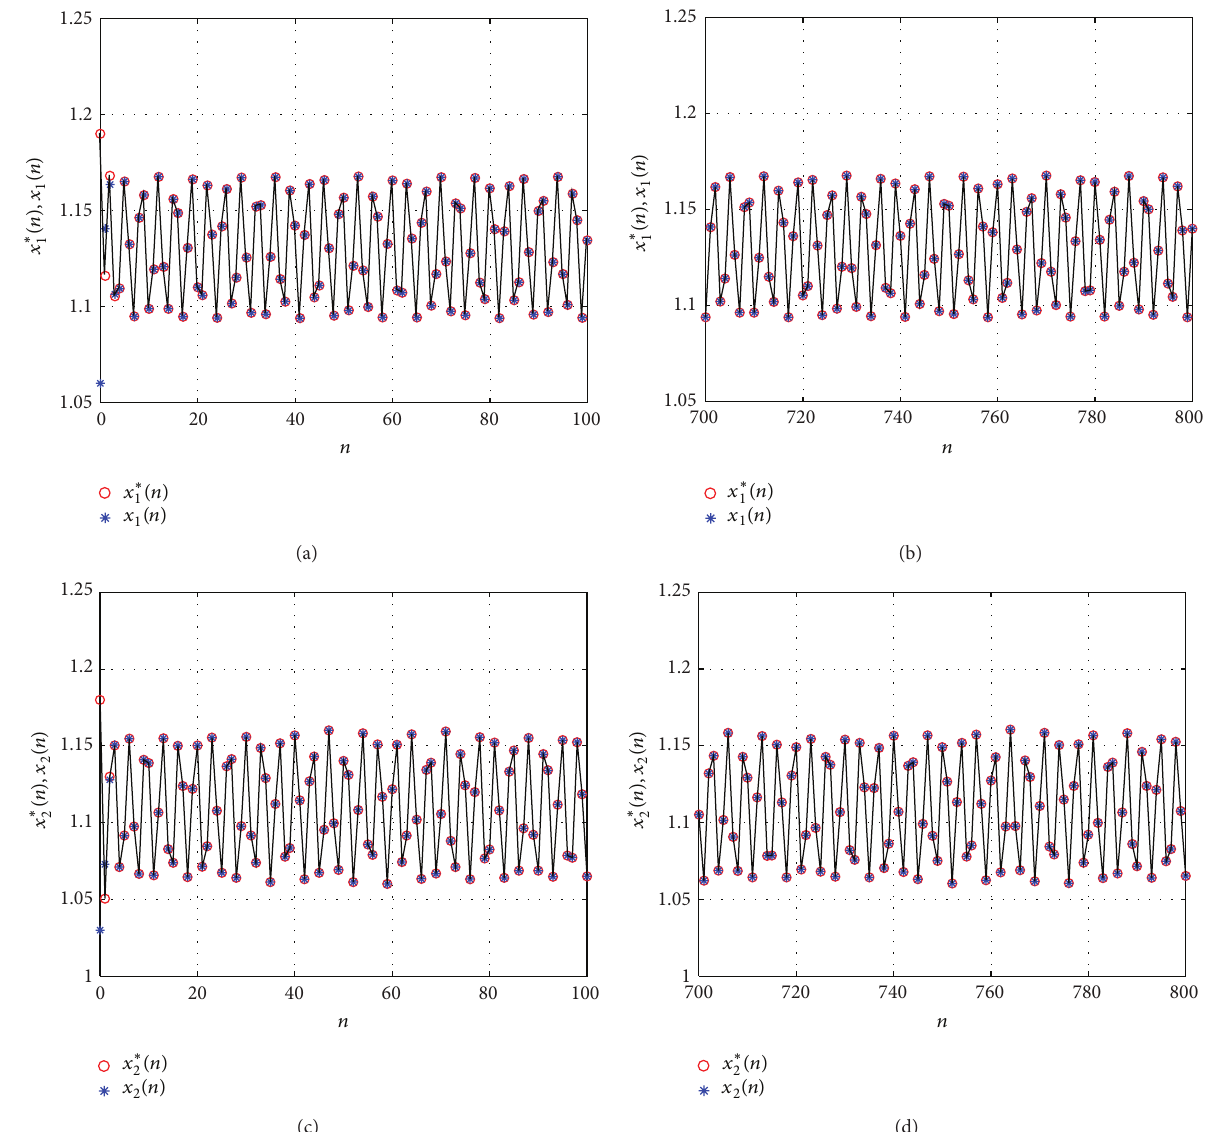
(0) = 1.06 , 𝑥 (0) = 1.03 for 𝑛 ∈ [0,100] , respectively. (b), (d) Time-series 𝑥 ∗ 1 2